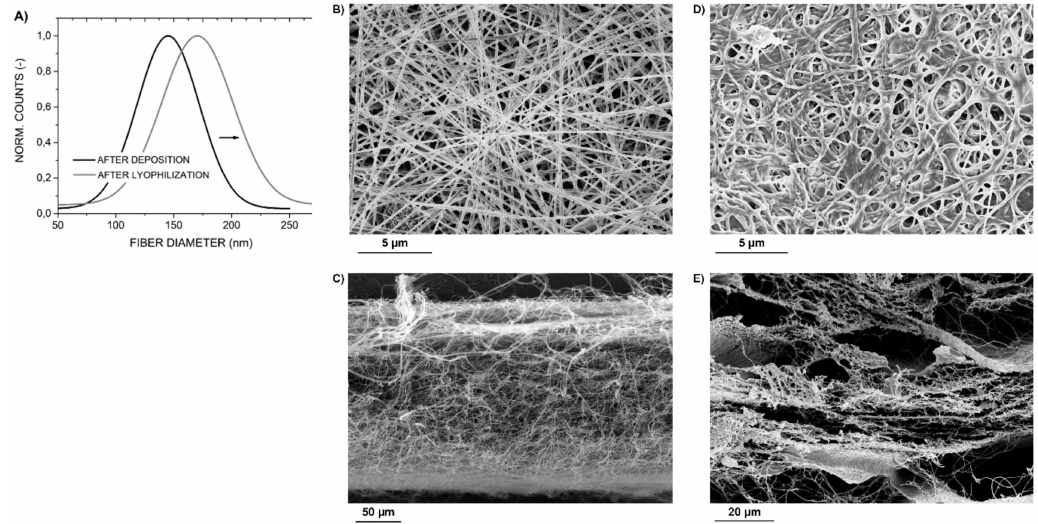
Figure 5. The distribution of fiber diameters after the deposition of the layer and after its cross-linking and lyophilization ( A ); corresponding SEM images of layer surfaces ( B , C ) and layer cross-sections ( D , E